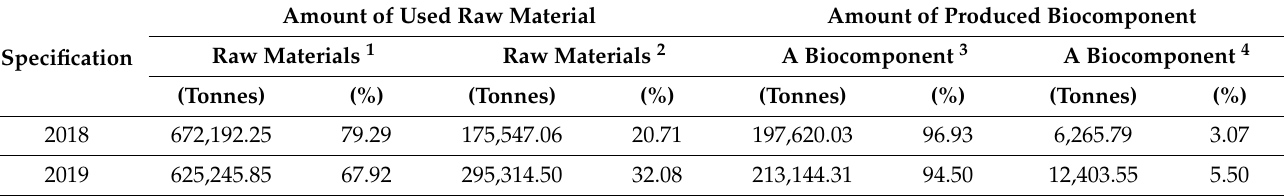
Table 5. The raw materials used in Poland to produce bioethanol in 2018–2019 [51].